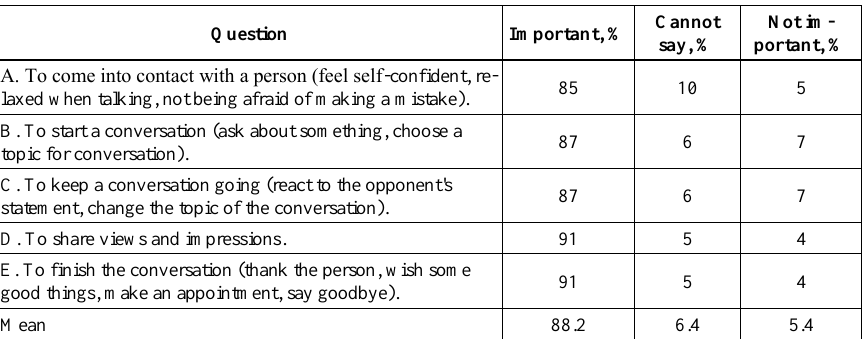
Table 7. Ability to conduct a free